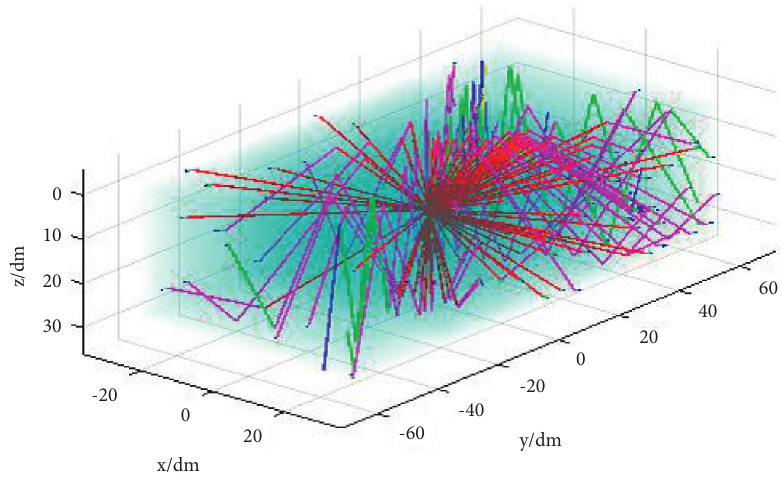
Figure 5: Path loss of any point propagating